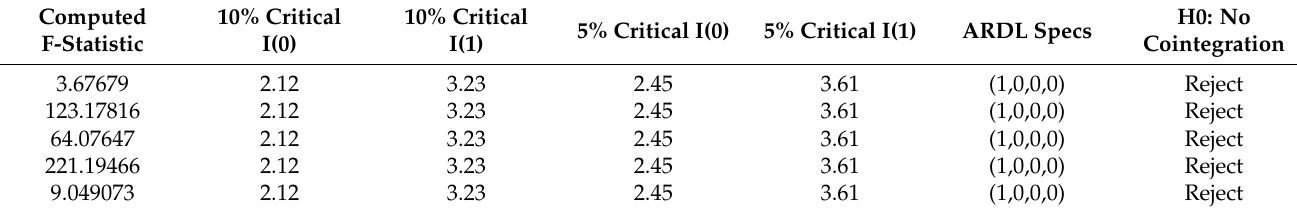
Table A5. The results of the bounds test for cointegration for